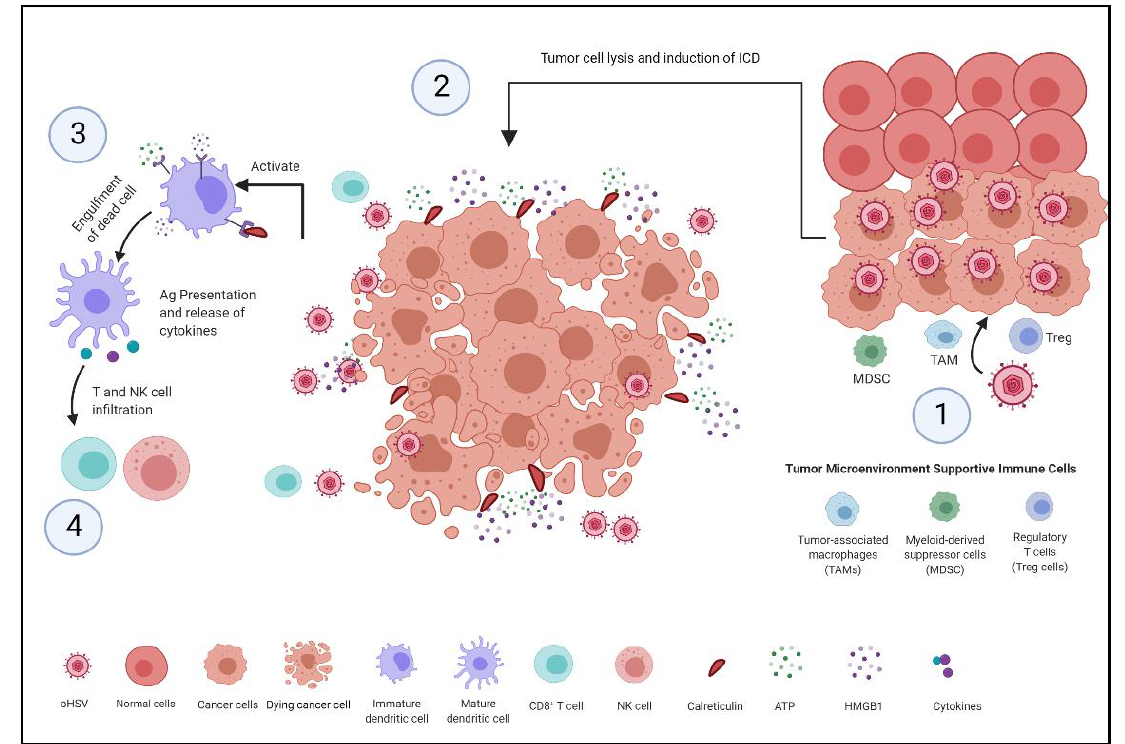
Figure 1. Mechanism of inducing antitumor immunity. (1) oHSV selectively infects and replicates in tumor cells. (2) Infected tumor cells undergo cell lysis and immunogenic cell death (ICD) [28]. The ICD process involves alterations in composition of the cell surface, such as expression of calreticulin (CRT), and the sequential release of damage-associated molecular patterns (DAMPs) such as ATP and high mobility group protein B1 (HMGB1) [20,28]. (3) These alterations and released mediators recruit and interact with receptors expressed on DCs, which recruits them to the tumor site to engulf, process and present tumor antigens [20]. (4) DCs secrete pro-inflammatory cytokines that stimulate natural killer cells and tumor-specific CD8 + T cells, thereby inducing immune-mediated tumor cell killing [20].